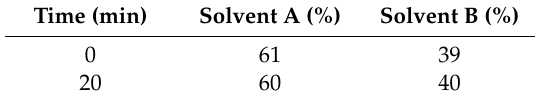
Table 1. Gradient elution system for HPLC analysis.